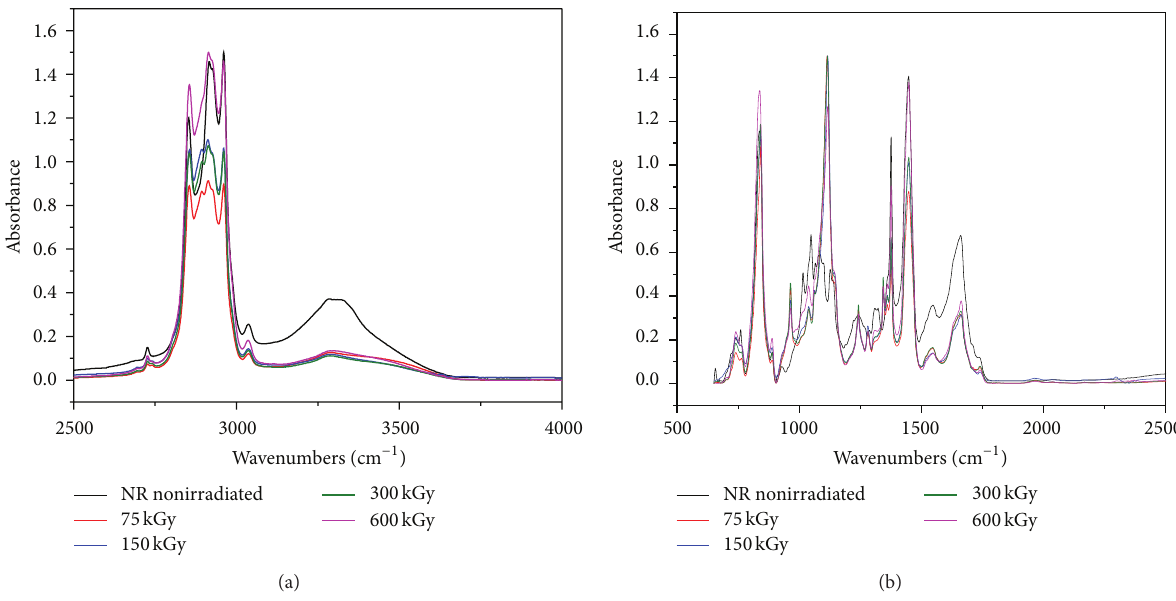
Figure 13: FTIR spectra for NR/hemp mixtures with 15phr hemp content: (a) between 2500–4000 and (b) between 500–2500.